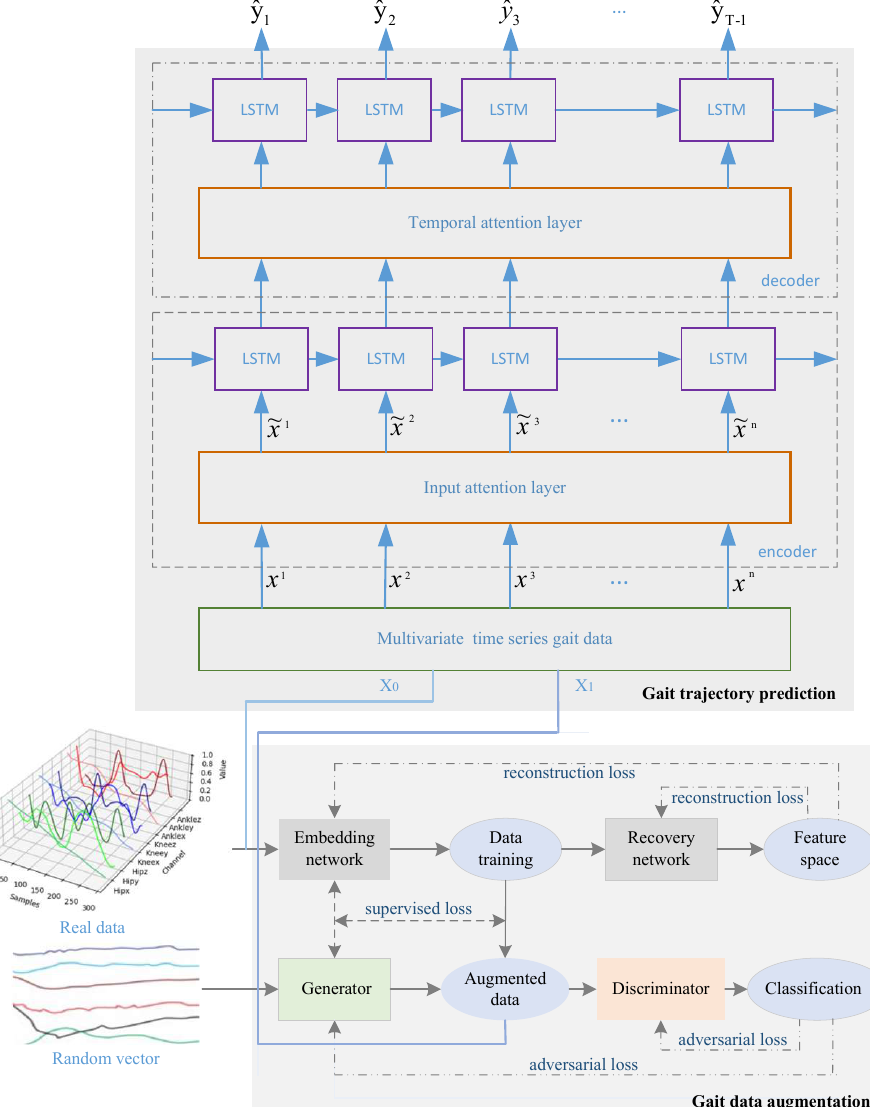
Figure 3. Pipeline of GAN-based gait data augmentation with attention-based gait trajectory